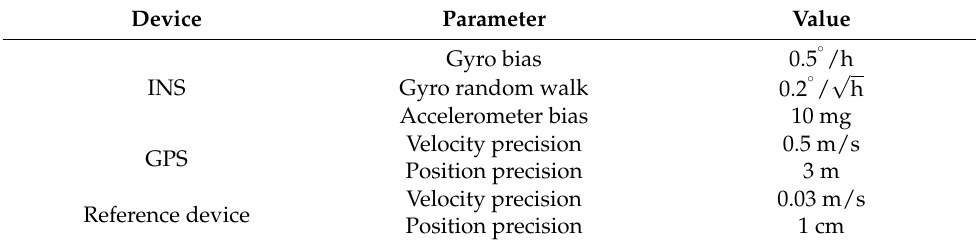
Table 1. The parameters of navigation devices.